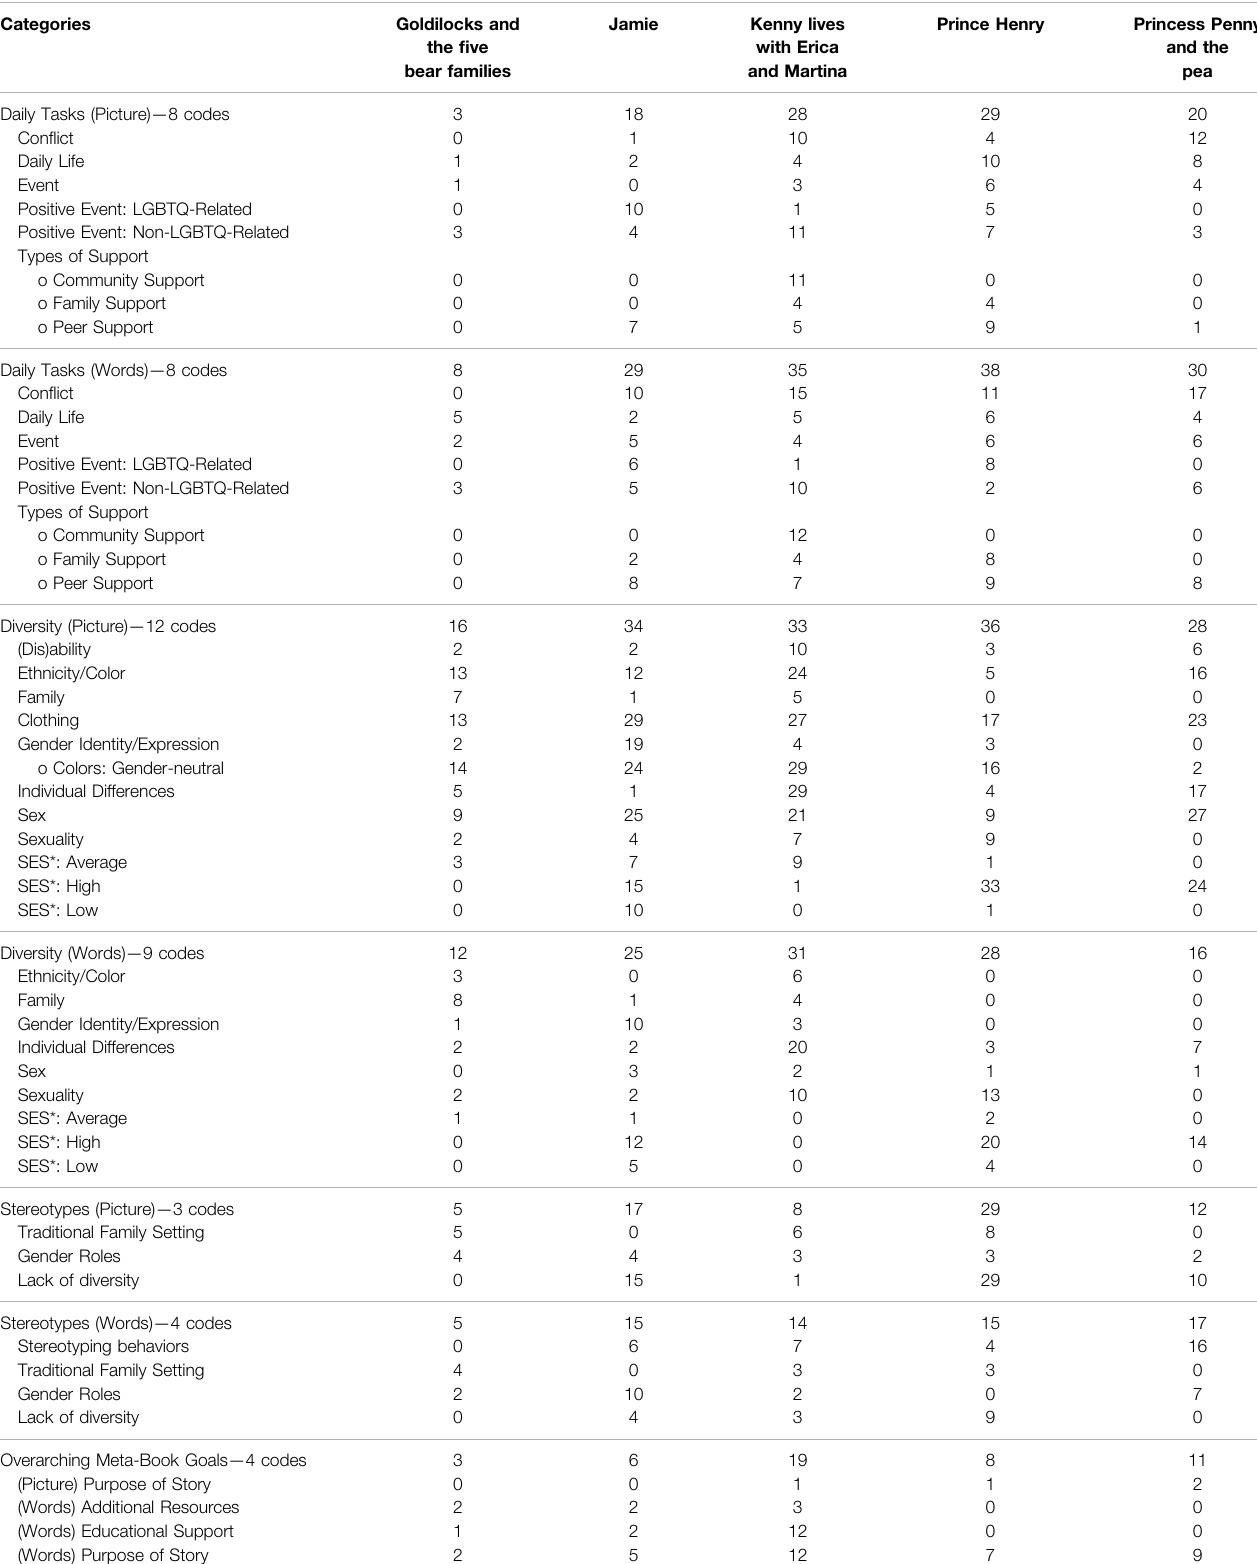
TABLE 2 | Frequency table of categories extracted from the fi ve LGBTQ-inclusive picture books.